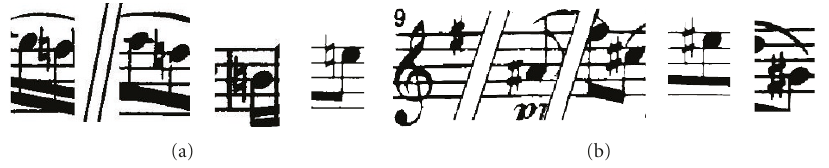
Figure 4: Typesetting variability between di ff erent publishings and also within the